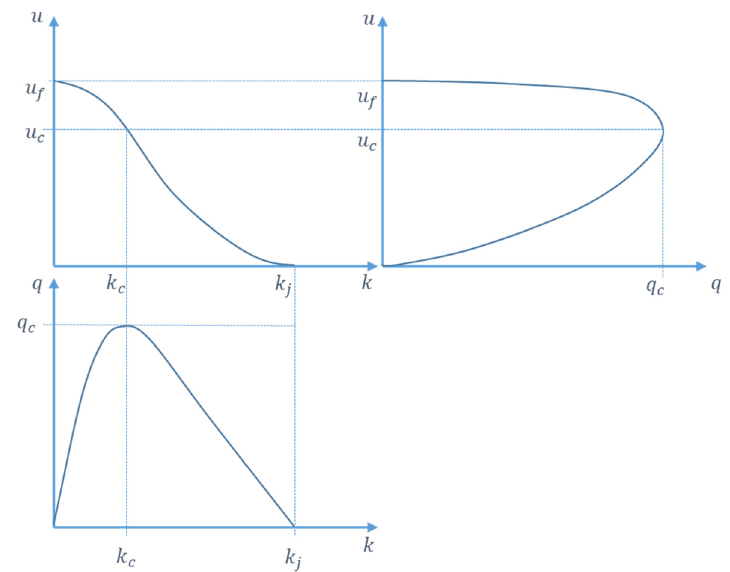
Figure 9. The fundamental diagram.